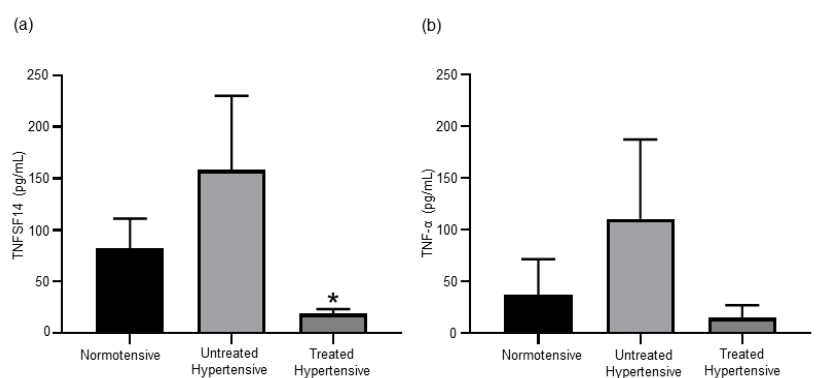
Figure 3. ( a ) The circulating levels of TNFSF14 was higher in the untreated hypertensive subjects. * Untreated hypertensive vs. treated hypertensive p = 0.033. ( b ) Serum TNF- α concentrations are elevated in untreated hypertensive subjects. n = 10–39 subjects/group. All data are presented as the mean ± SEM. TNFSF14, tumour necrosis factor superfamily member 14.